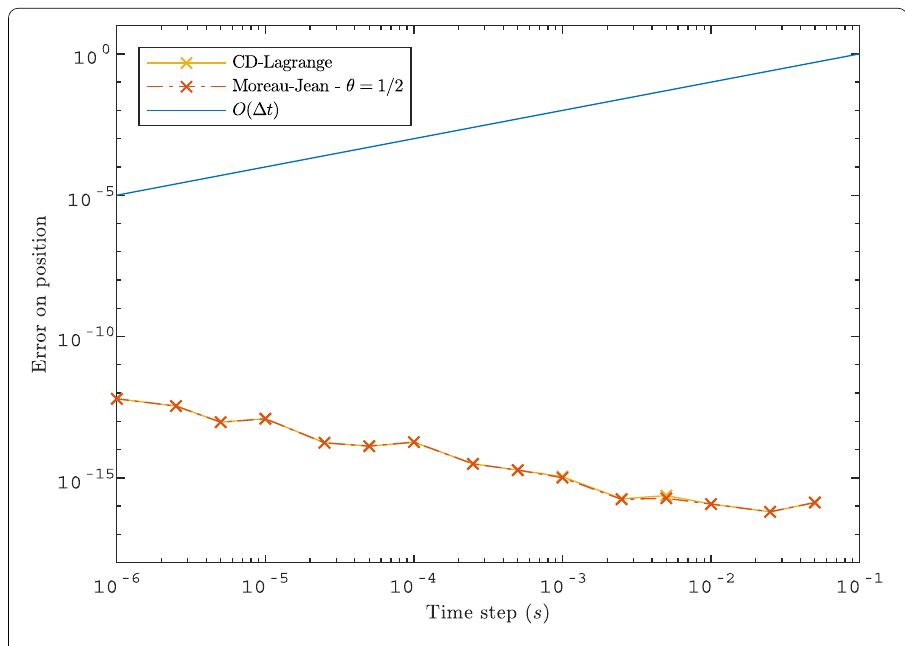
Fig. 8 Bouncing ball—convergence order for position without impact